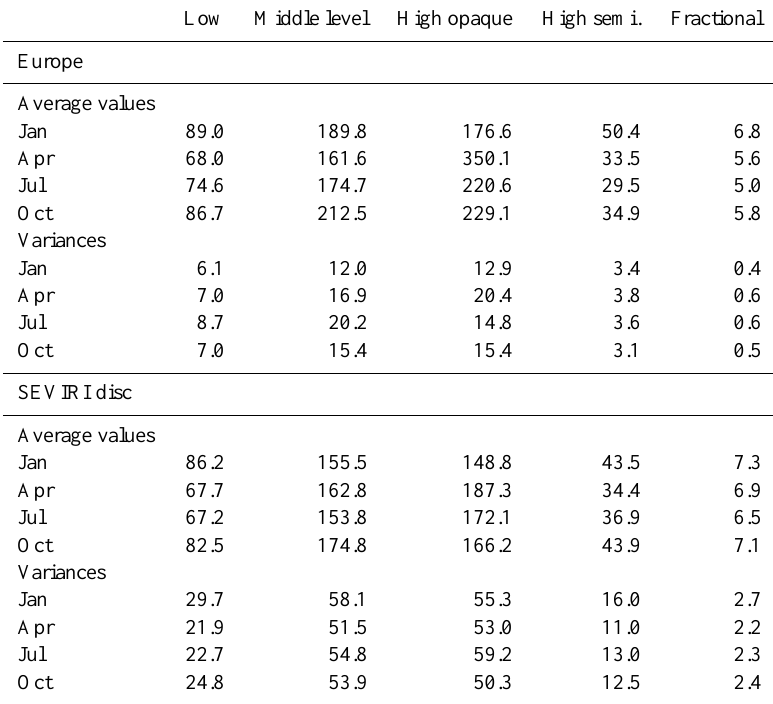
Table 4. Average LWP (gm − 2 ) for Europe and SEVIRI disc for January, April, July and October 2009 based on level 2 data, only cloudy pixels were averaged. Low Middle level High opaque High semi. Fractional Europe Average